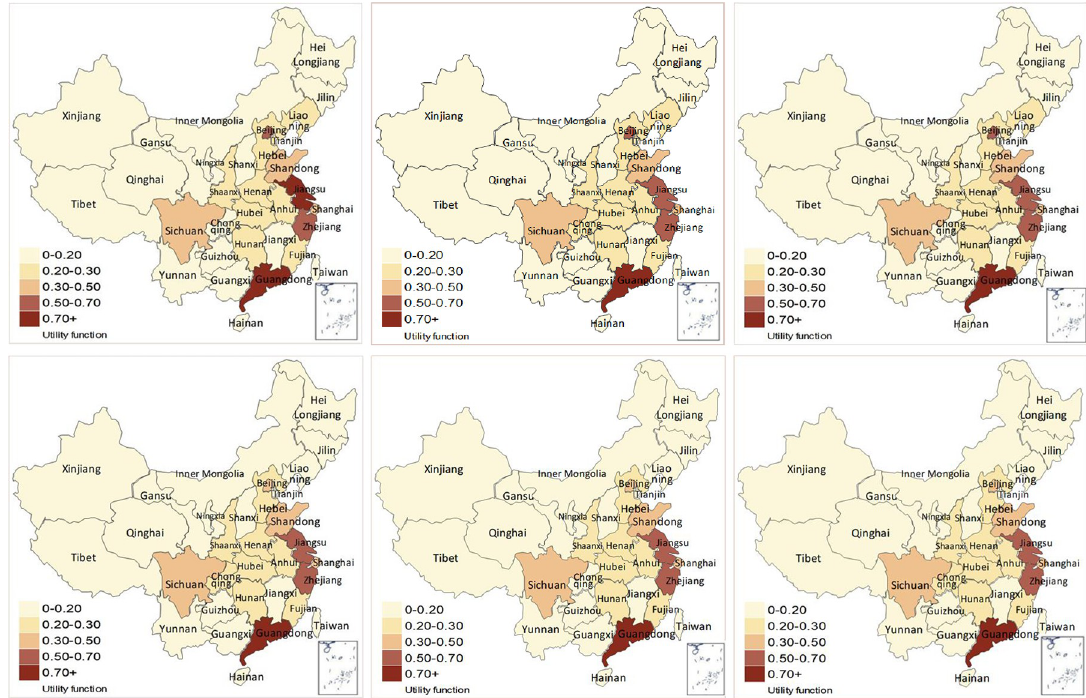
Fig 5. The utility function values of 31 provincial level regions from 2015 to 2020. (Reprinted from [41] under a CC BY license, with permission from Professor Sen Guo, original copyright 2019). (a) The utility function values of 31 regions in 2015. (b) The utility function values of 31 regions in 2016. (c) The utility function values of 31 regions in 2017. (d) The utility function values of 31 regions in 2018. (e) The utility function values of 31 regions in 2019. (f) The utility function values of 31 regions in 2020.